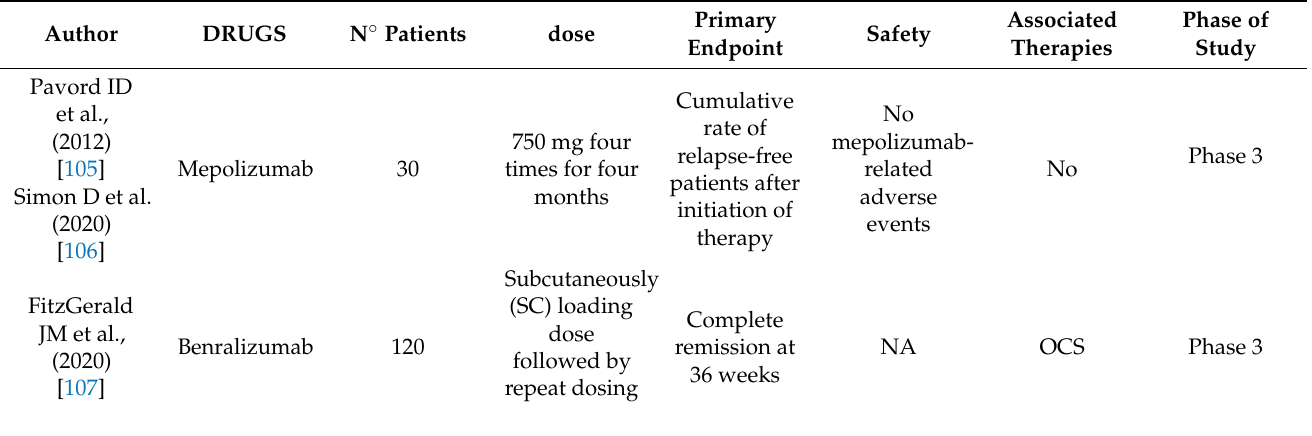
Table 4. Studies summarizing miscellaneous treatments for